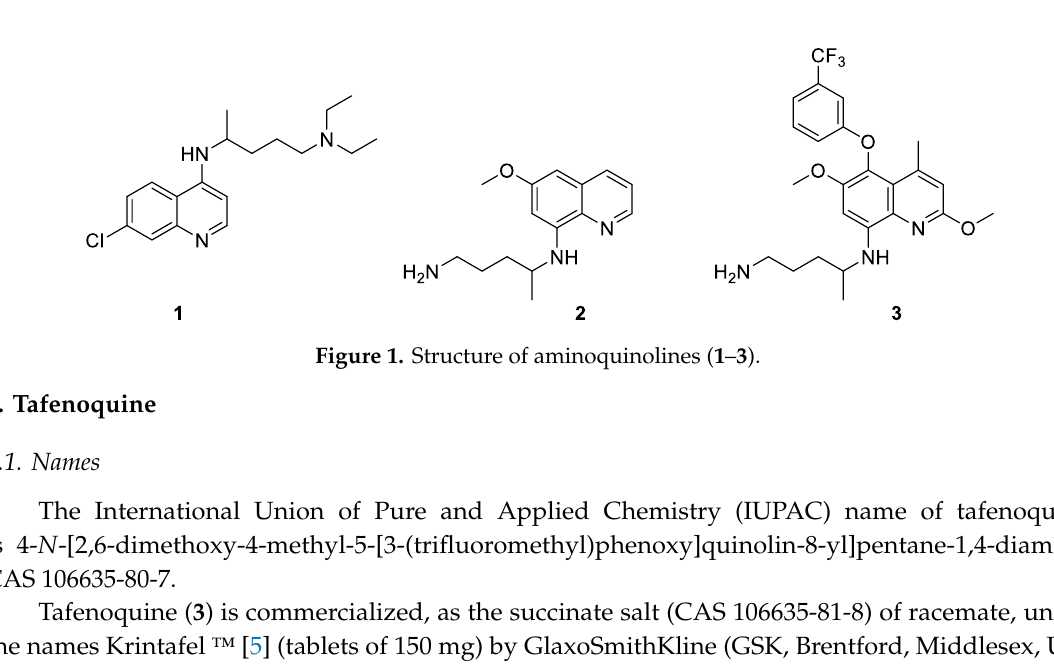
Figure 1. Structure of aminoquinolines ( 1–3) .